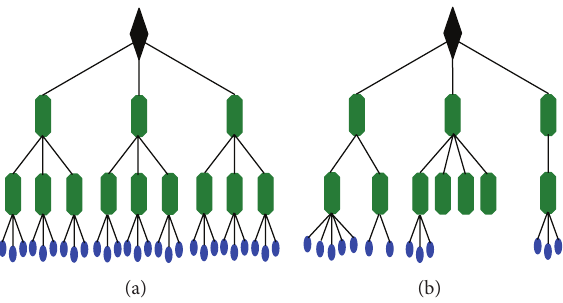
Figure 2: Traditional vocabulary tree (a) and new vocabulary tree